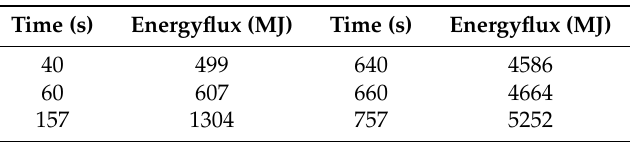
Table 3. Energy fluxes evaluated on the control Surface A in the three different case studies for the time of the door opening and the total